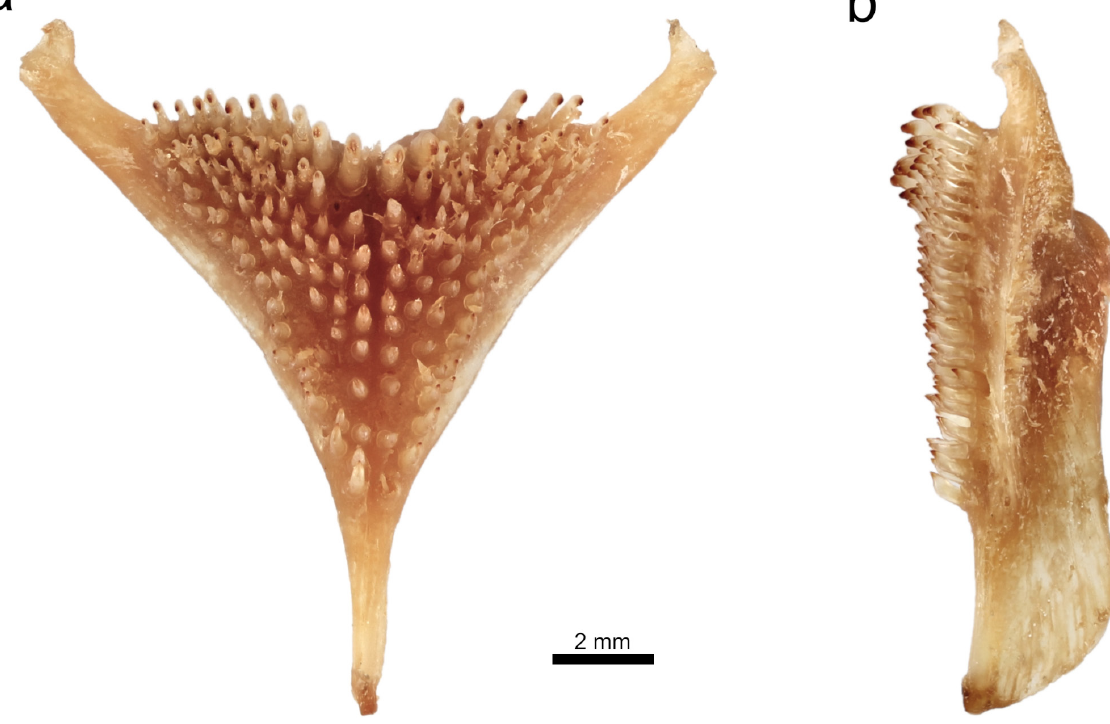
Fig. 25. Haplochromis kimondo sp. nov. (RMCA 2018.008.P.0364; 128.1 mm SL). a . Dorsal view of the lower pharyngeal jaw. b . Lateral view of the lower pharyngeal